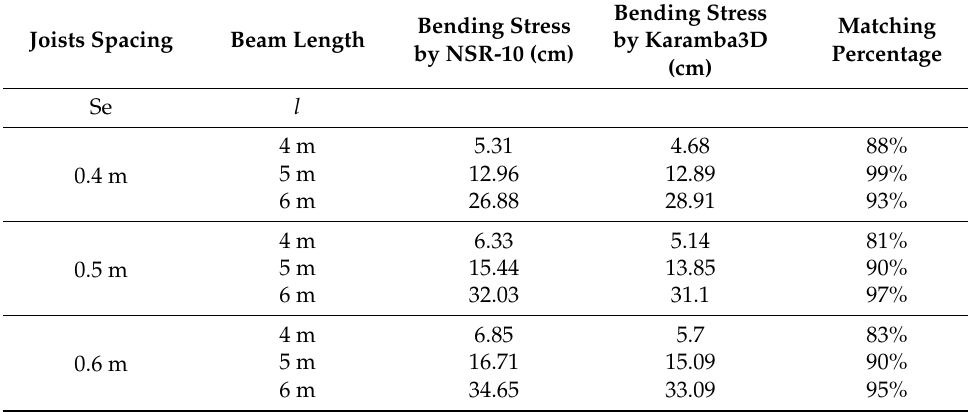
Table 7. Comparison of deflection